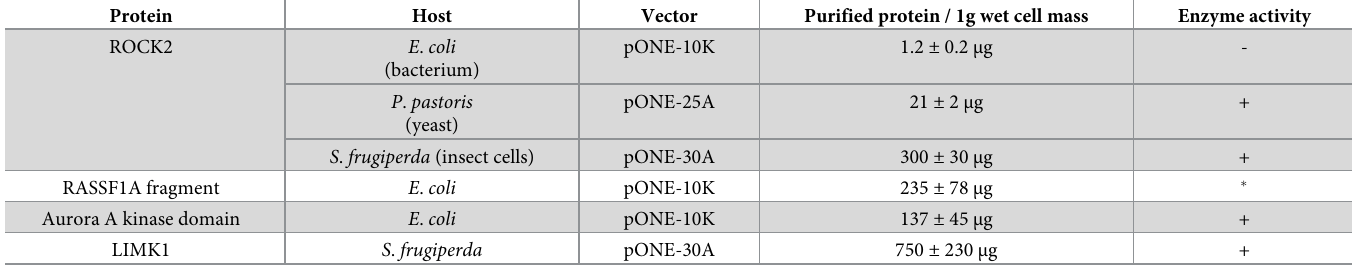
+/- signs mark if the enzyme was found active. � marks that RASSF1A inherently lacks enzyme